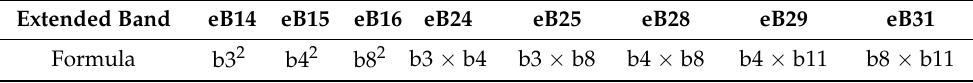
Table 3. Suitable extended bands (eB) for automatic identification of Li-bearing pegmatites.